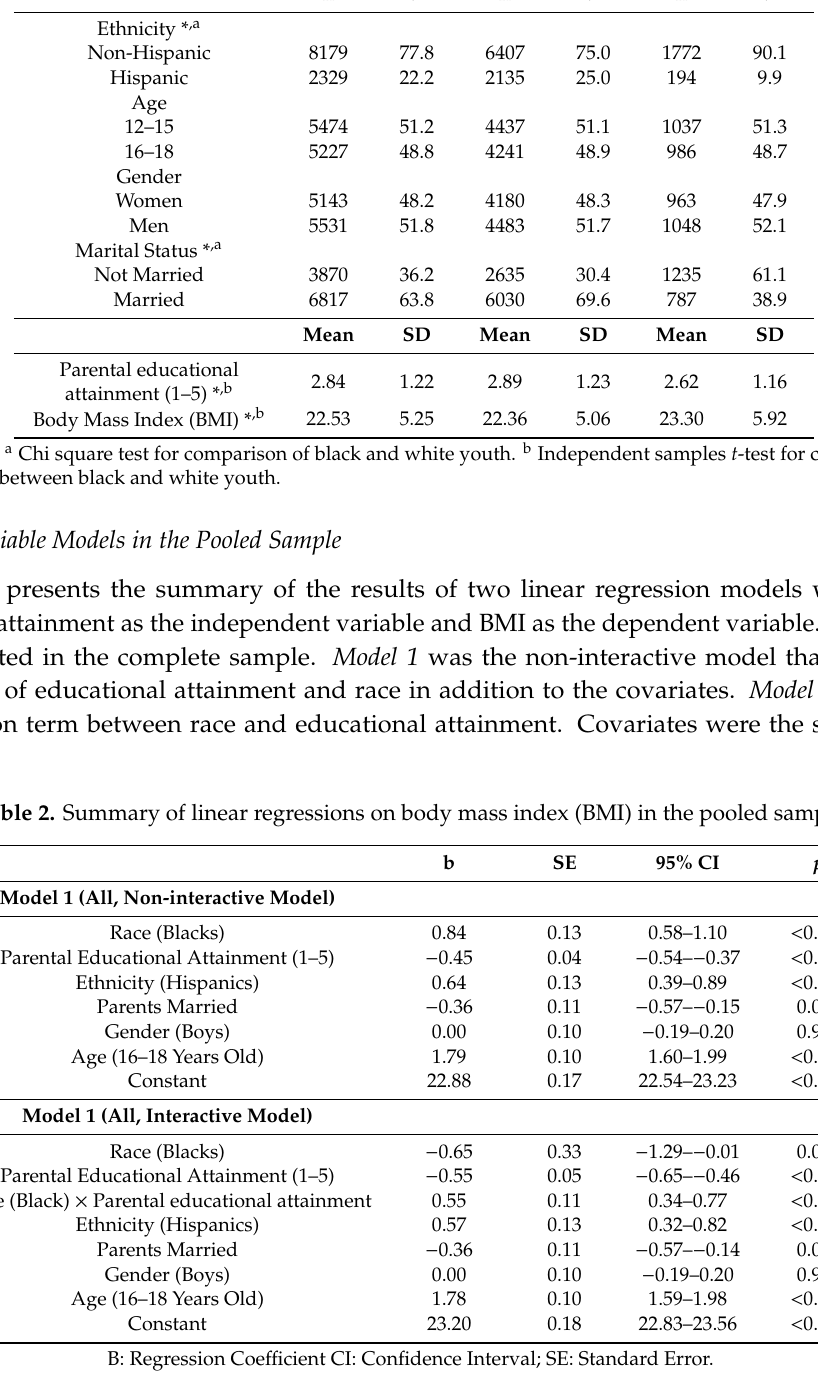
B: Regression Coe ffi cient CI: Confidence Interval; SE: Standard